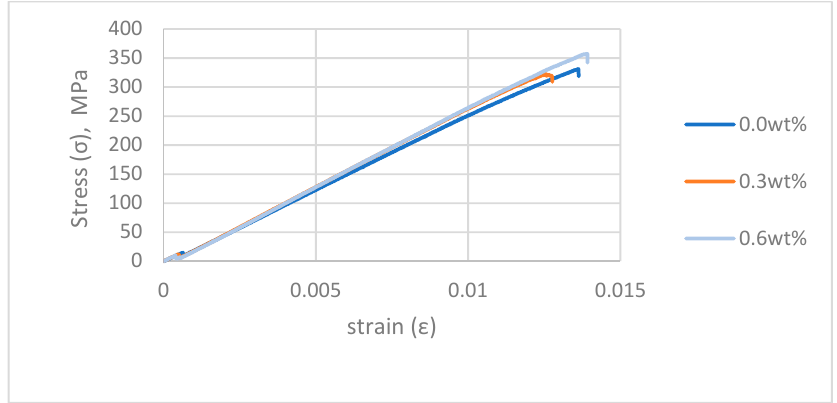
Figure 9. The representative stress–strain curves of 1 mm composites.